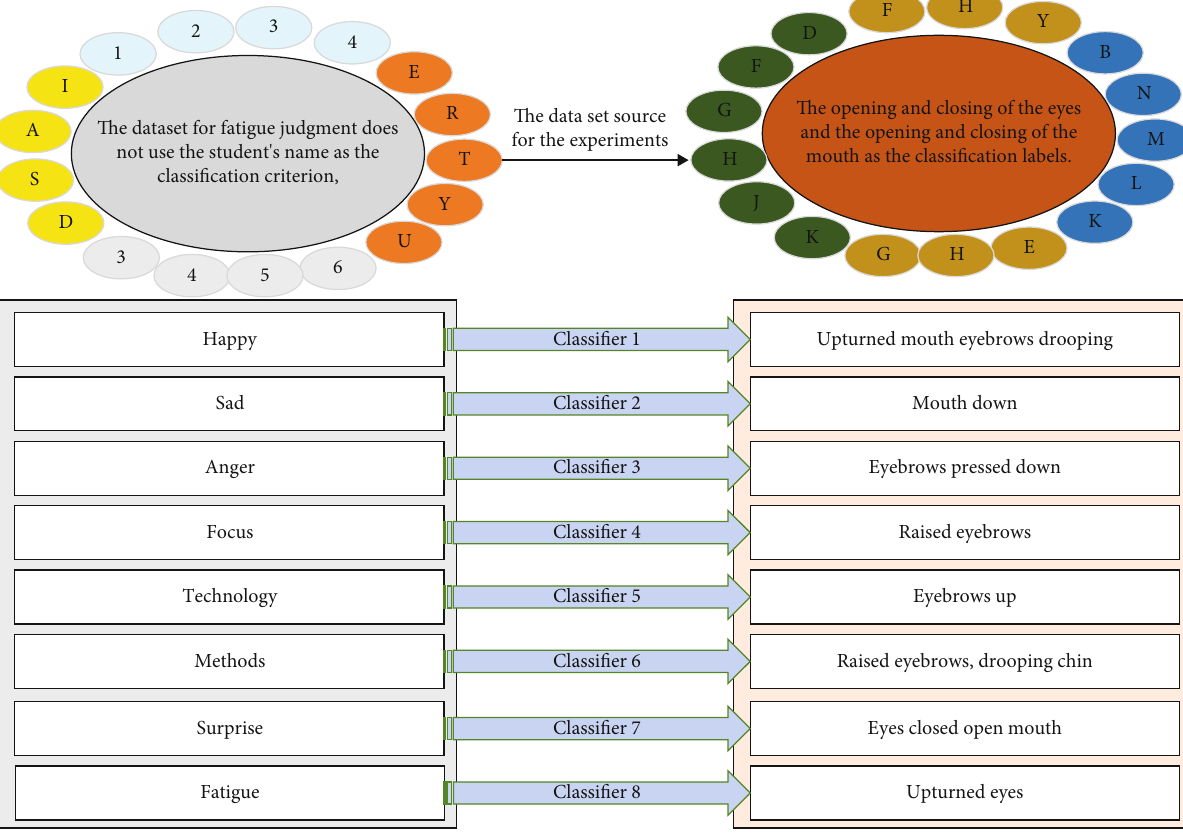
Figure 2: Relationship between basic emotion and expression tendency